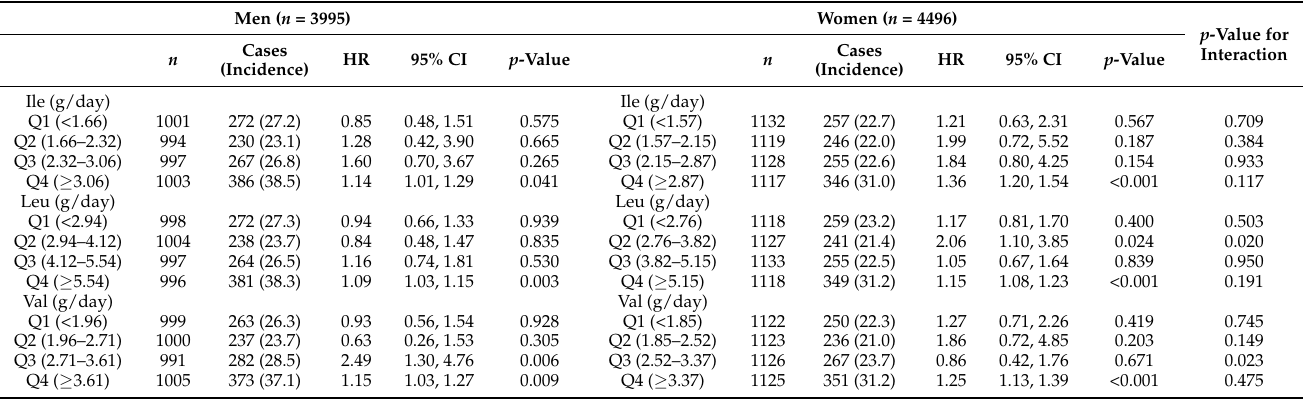
Table 4. Adjusted associations between hypertension incidence and continuous variables of BCAAs in subgroups divided using quartiles ( n =